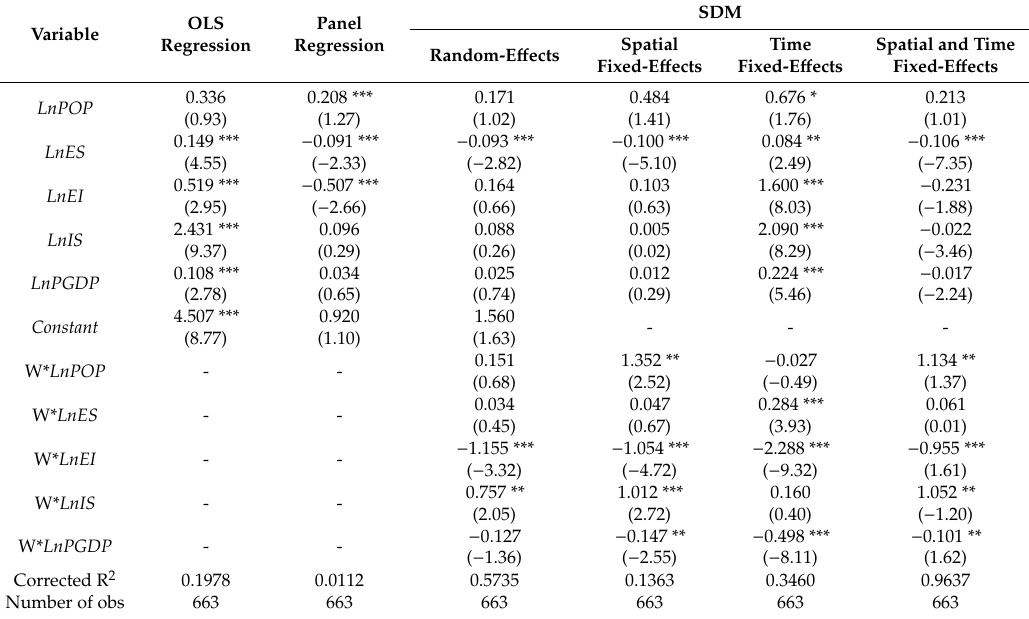
Table 4. The econometric regression results concerning the embodied GHGs in export trade.